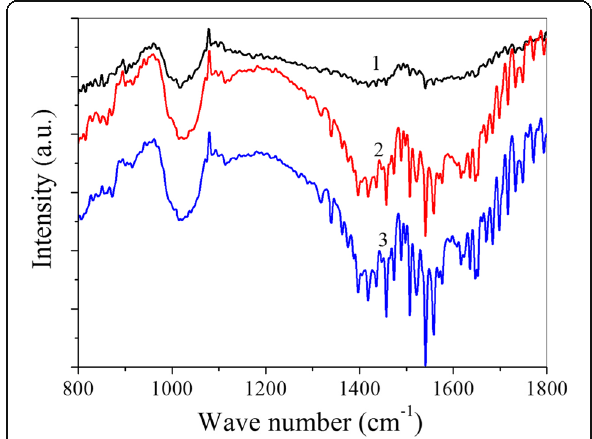
Fig. 5 Infrared spectra of Cu-Ti ( 1 ), Cu-Ti 1 vol% MWCNTs ( 2 ) and Cu-Ti 3 vol% MWCNTs ( 3